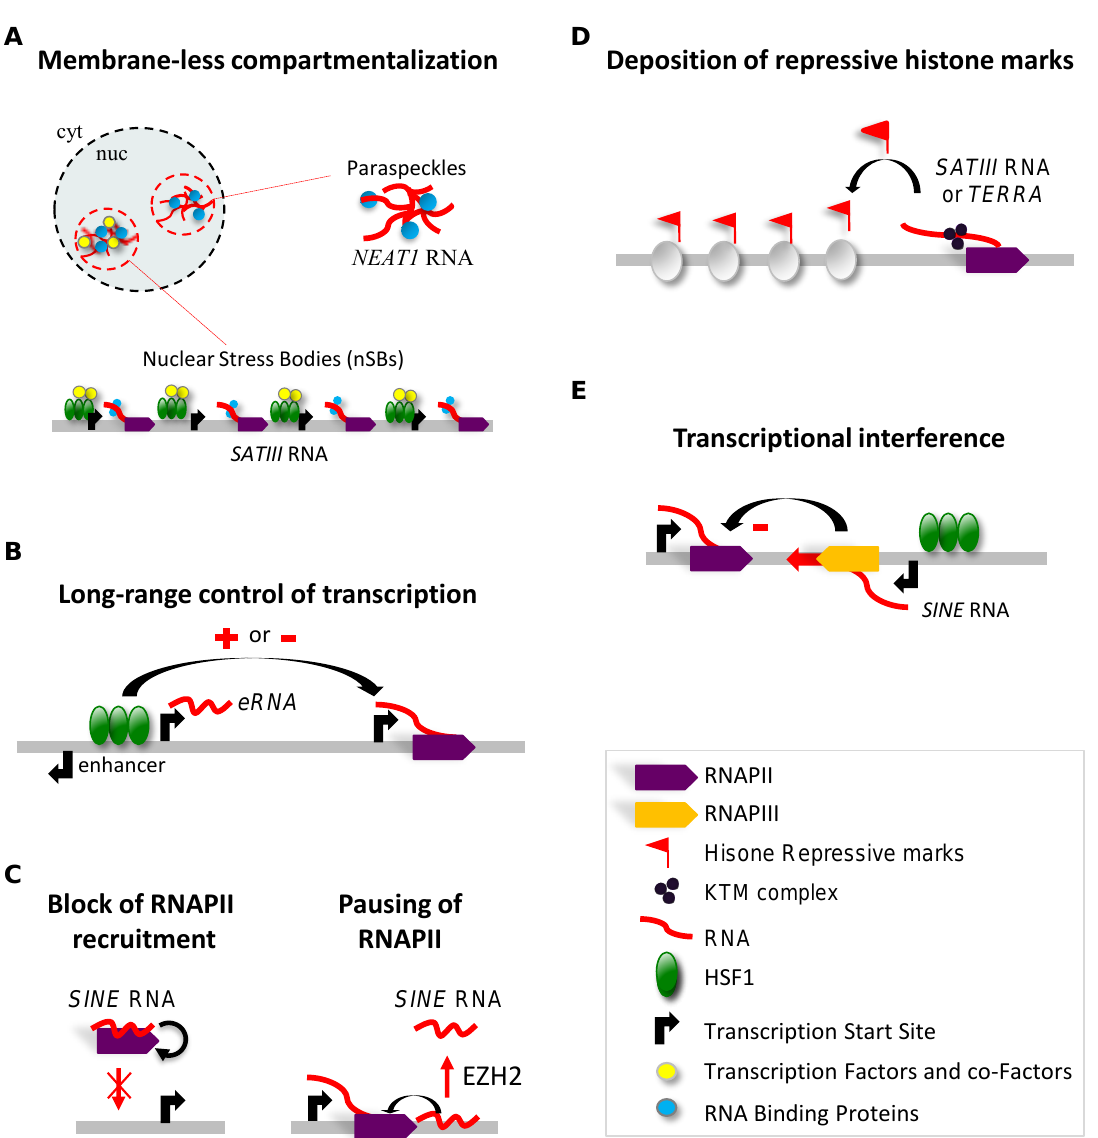
Figure 2. Molecular roles assigned to the non(protein)-coding RNAs in the heat shock